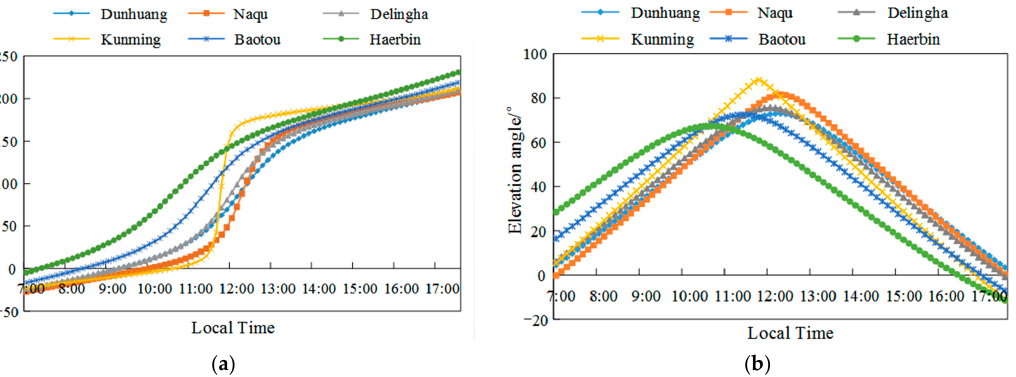
Figure 4. Variation of solar position on the summer solstice in different regions: ( a ) azimuth angle; and ( b ) elevation angle.